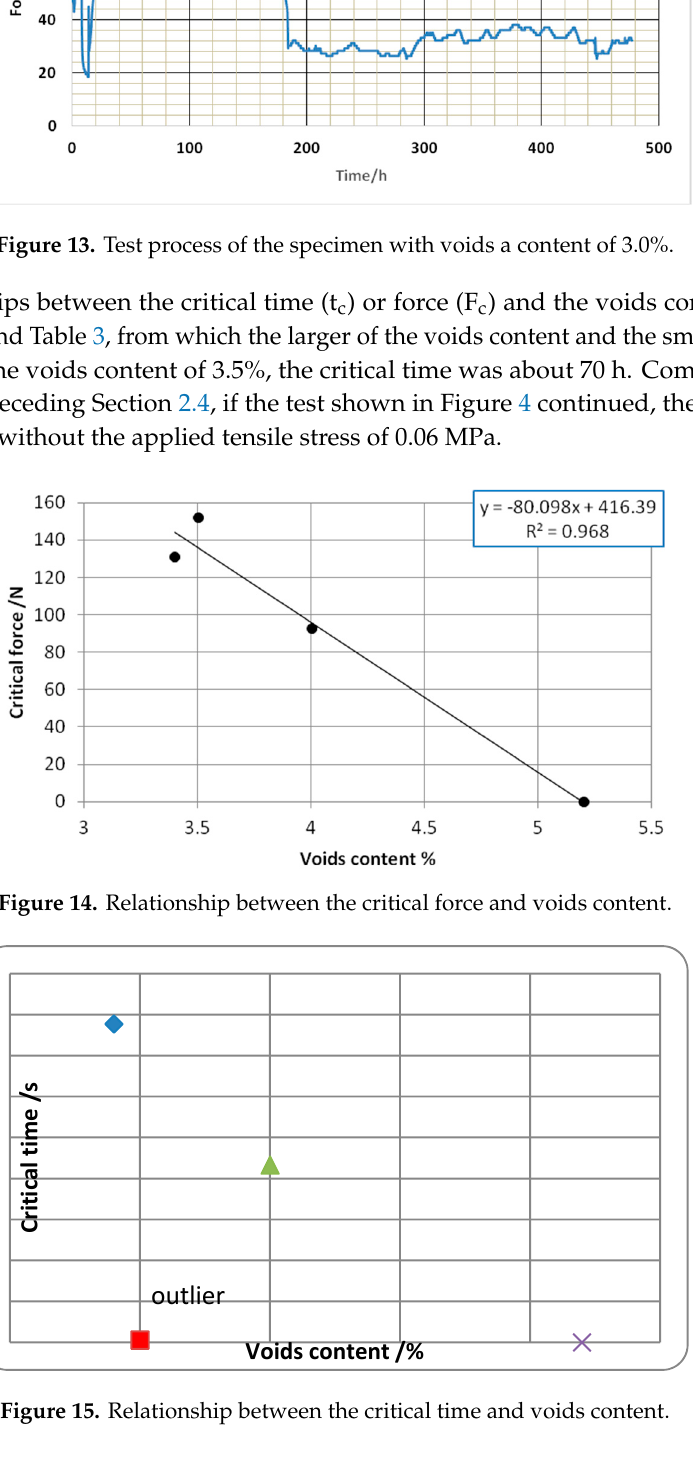
Figure 13. Test process of the specimen with voids a content of 3.0%.